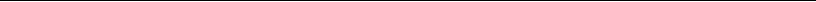
Bootstrap samples Table 5 CFA results: Cross‑validity